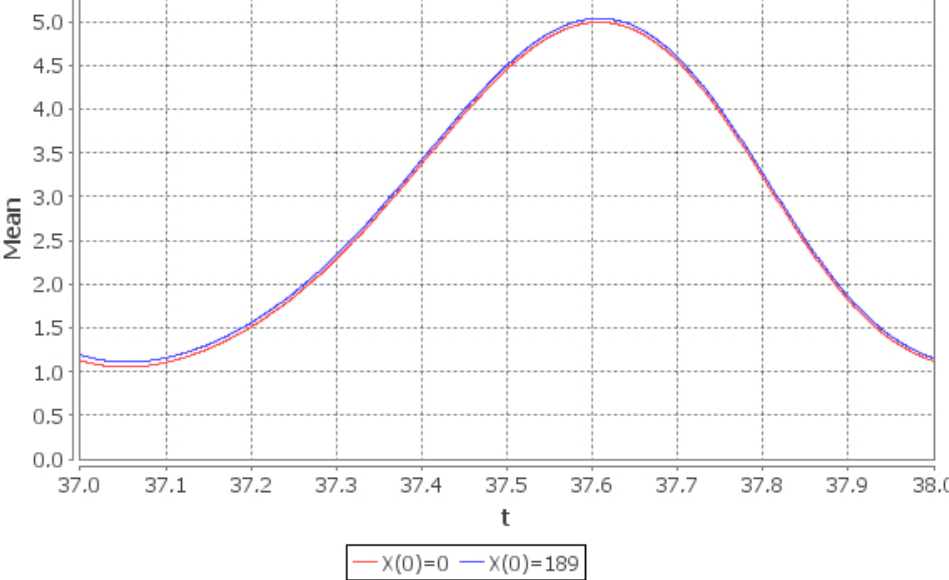
Figure 4. Limiting conditional mean E ( t , k ) number of customers in the system: E ( t ,0 ) ( red line ), E ( t ,189 ) ( blue line